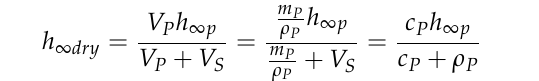
Figure 3. Diagram of the parabolic profile of the coating thickness after film draining at time t . The theoretical “dry” coating ℎ (cid:2998)(cid:3031)(cid:3045)(cid:3052) thickness was calculated as: